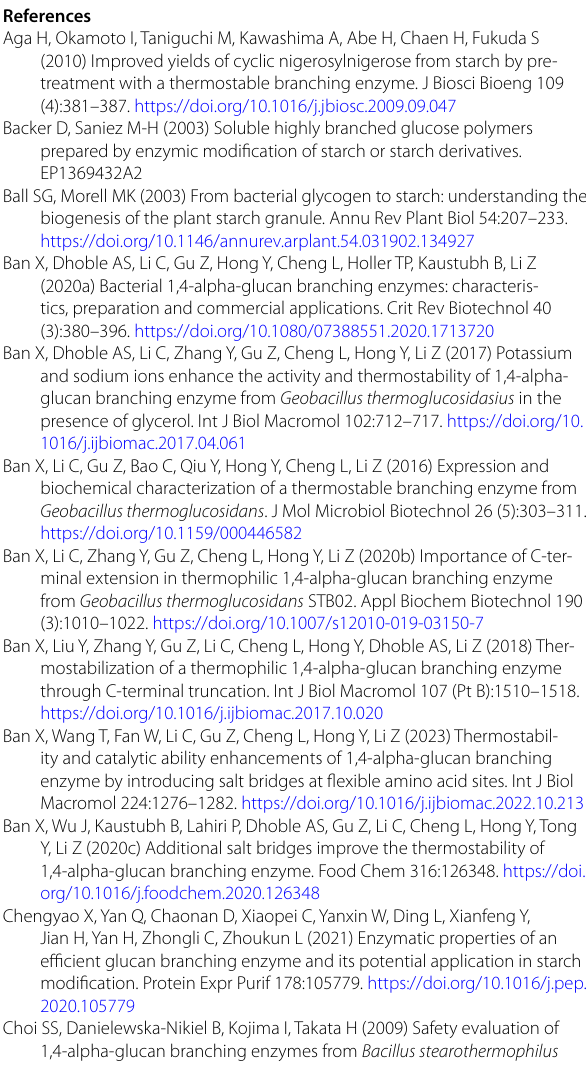
Additional file 1: Table S1. Strains and plasmids used in this study. Table S2. The identity percentage for alignment between bl-GBE and ten GBE sequences obtained from literature mining. Table S3. Relevant index of protein